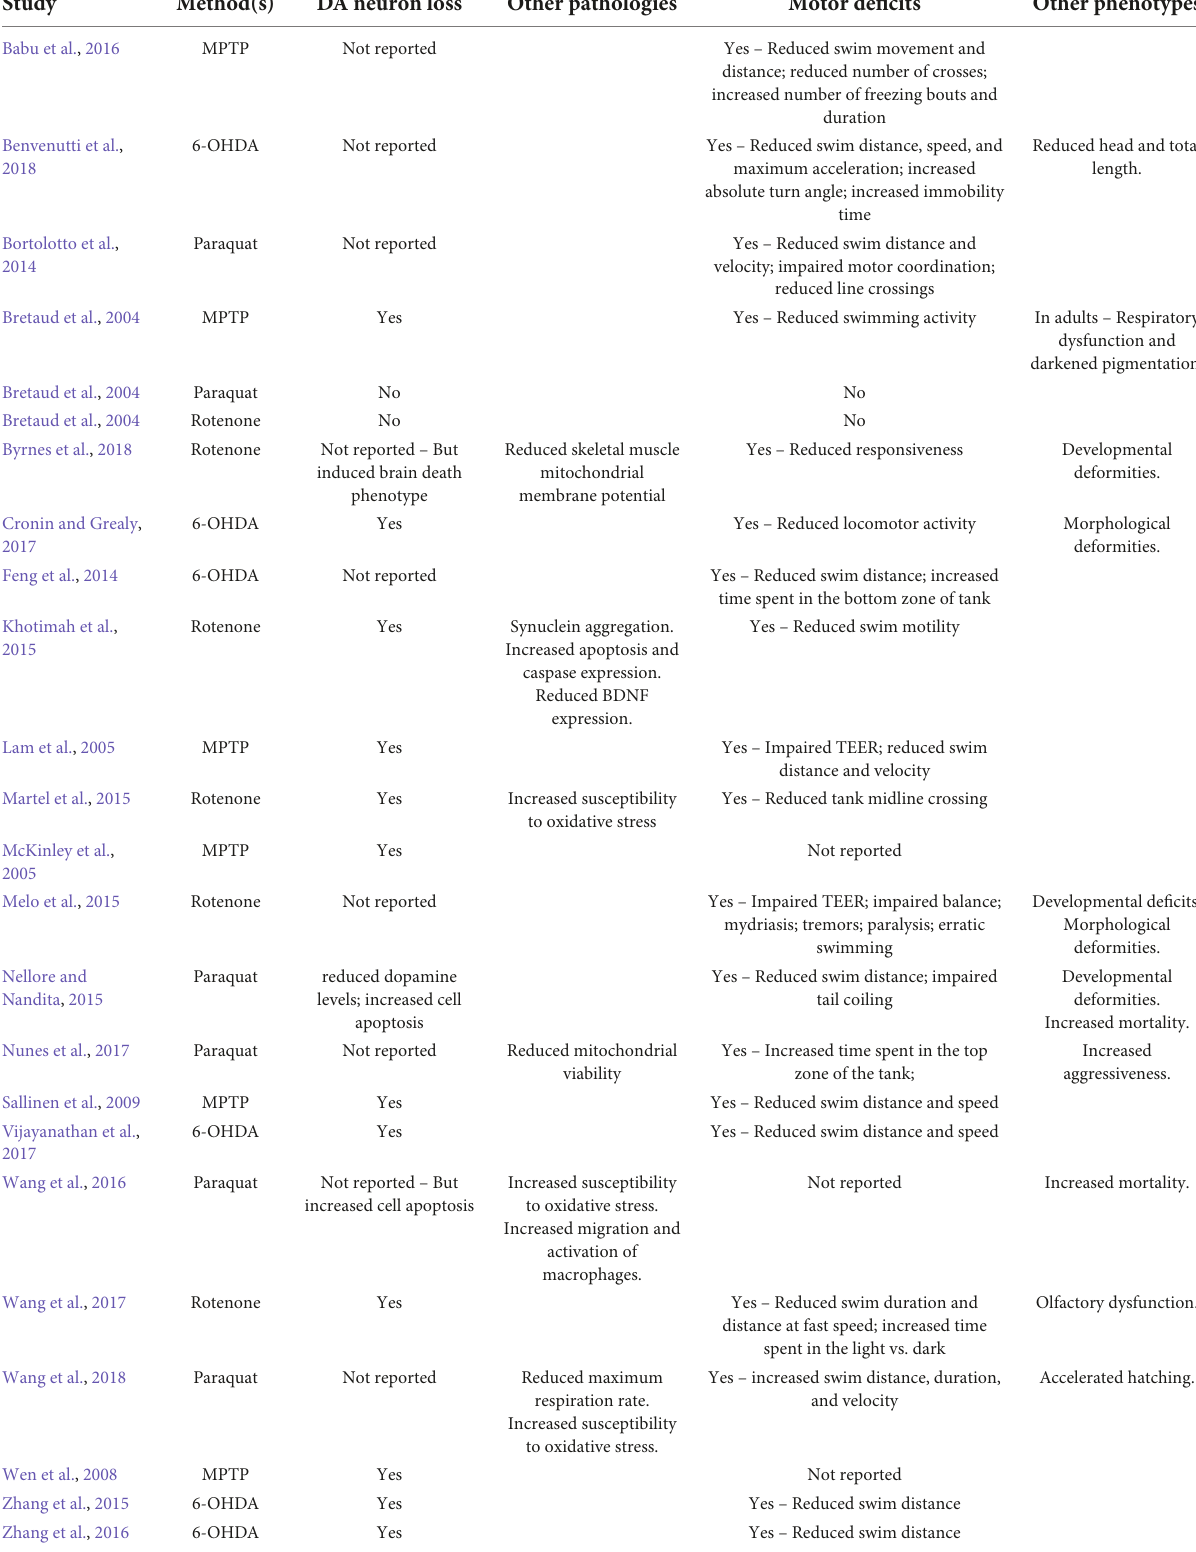
TABLE 2 Chemical zebrafish models of